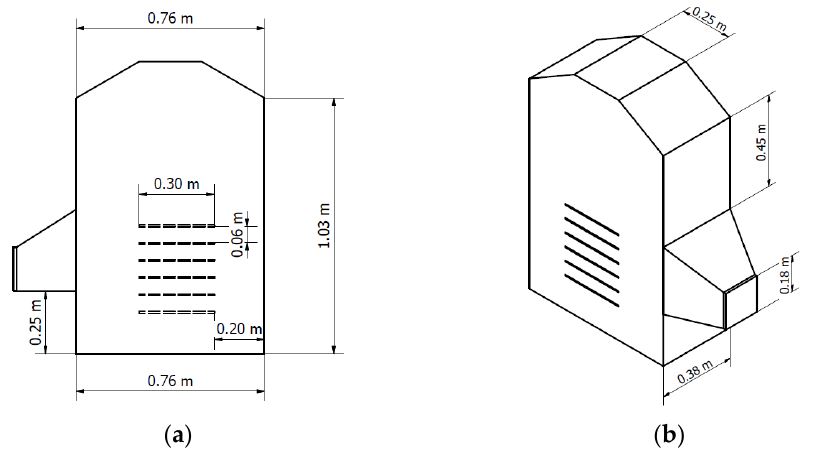
Figure 1. Dimensions of the convective drying chamber. ( a ) Lateral view and ( b ) Diagonal view.